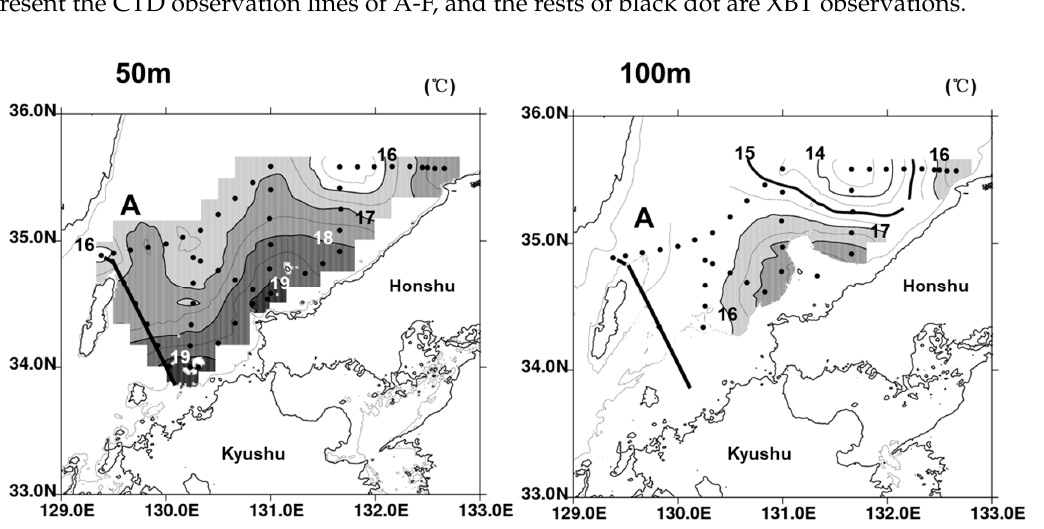
Figure 3. Horizontal distributions of temperature around the Tsushima / Korean Strait, at the depths of 50 m and 100 m.